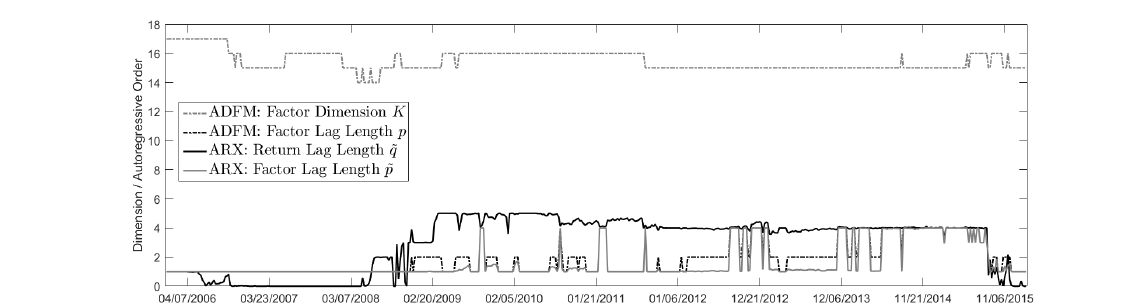
Figure A2. Decomposition of the S&P500 log-returns predicted for the next week.